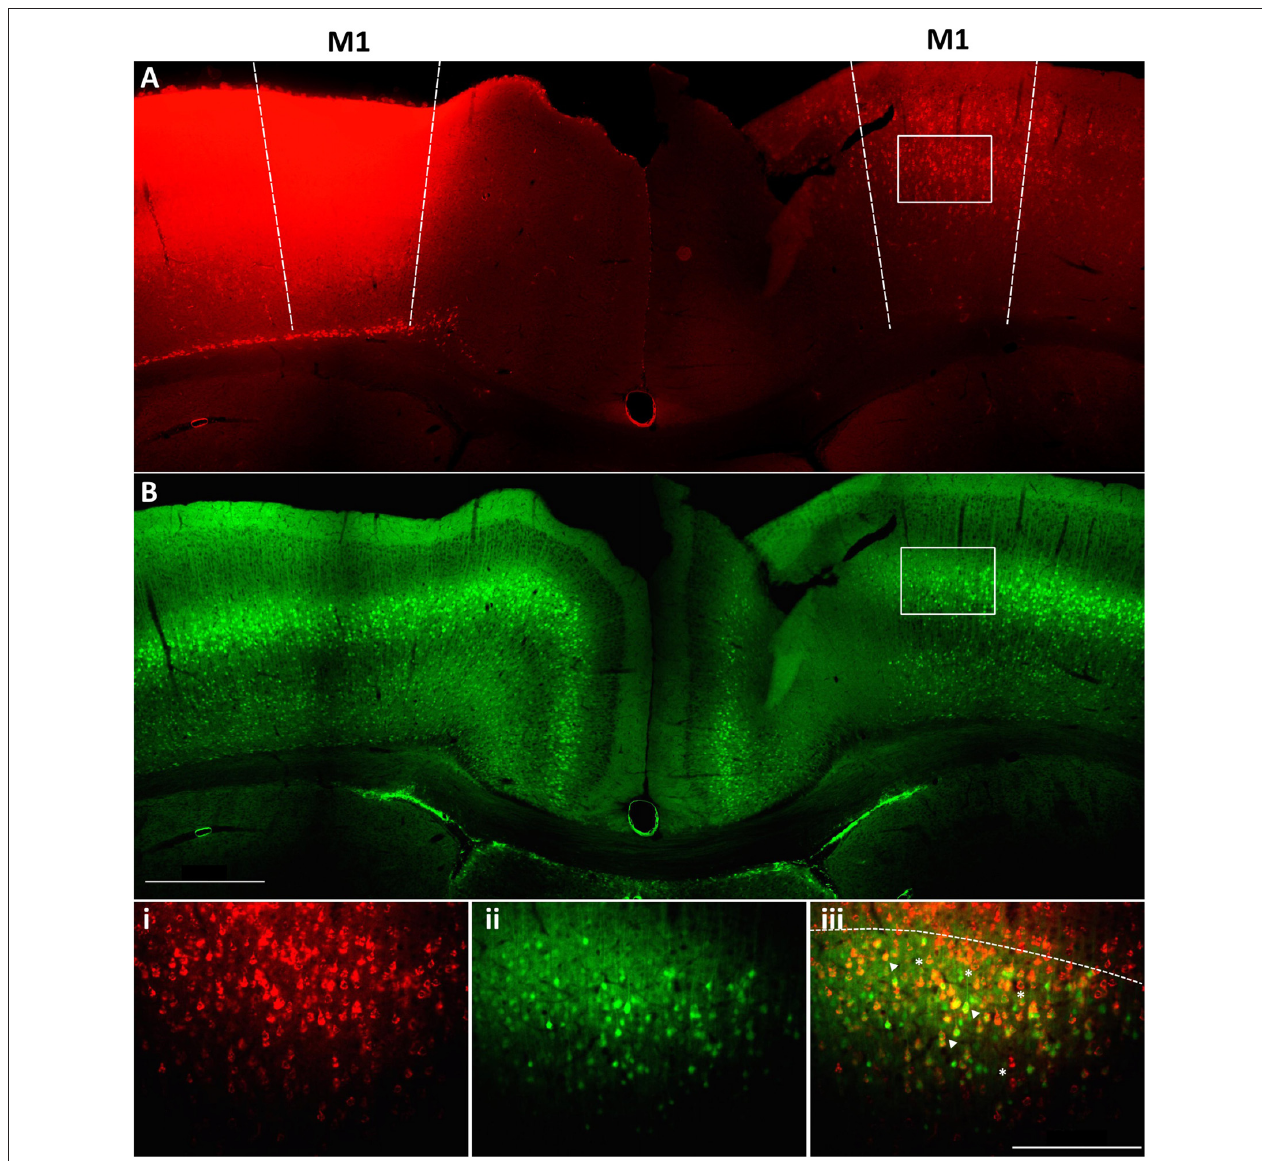
FIGURE 1 | Retrograde labeling to target Fezf2+ve and Fezf2 − ve IT-PNs in M1. A cholera toxin subunit b retrograde tracer conjugated to Alexa 647 (CTB647) was injected into the left hemisphere M1 of a Fezf2-Gfp mouse. (A) Image shows neurons labeled with retrograde tracer (red). (B) Fezf2 -GFP expression in the same section (green). White box indicates area taken at higher magnification (i) CTB647 labeling, (ii) GFP expression, (iii) overlay of GFP and CTB647. Neurons in the contralateral hemisphere were labeled with CTB647, including Fezf2 -GFP positive (arrowhead) and Fezf2 -GFP negative (asterisk) neurons in layer 5. Dashed line in bottom panel indicates layer 2/3 and layer 5 boundary. Image was taken at Bregma 0.4. Scale bar is 500 µ m or 200 µ m (bottom